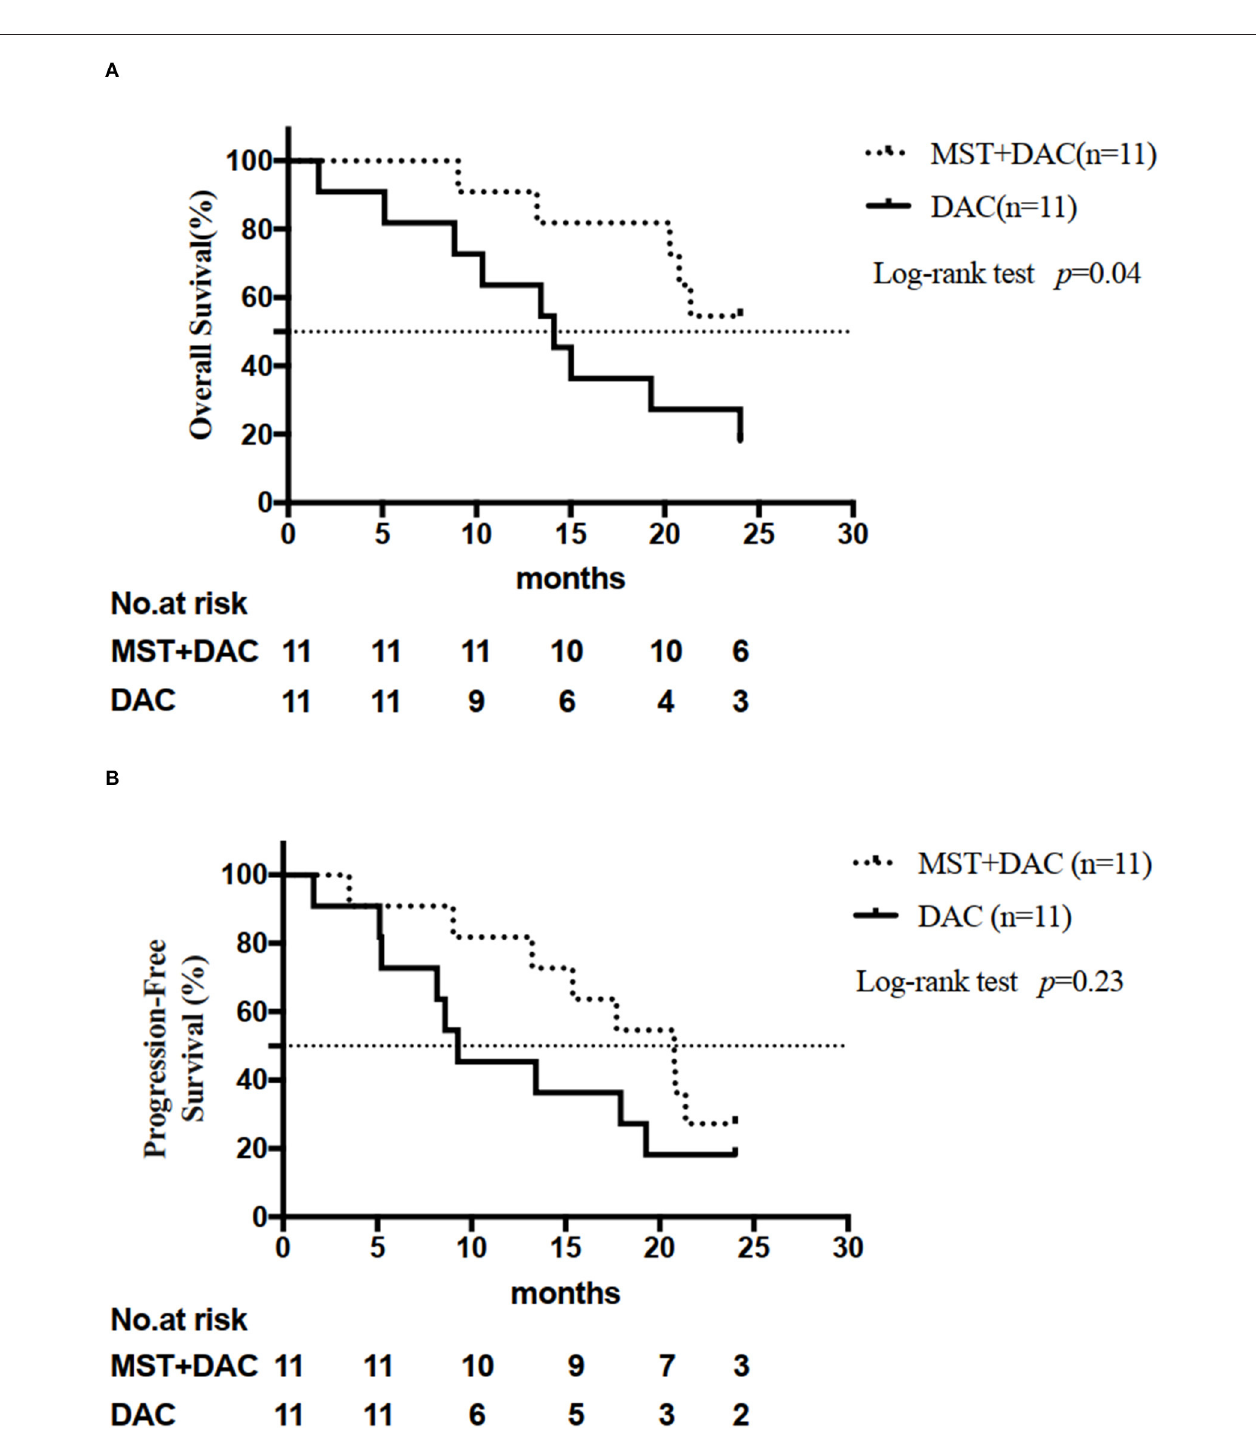
FIGURE 1 | Analysis of efficacy endpoints. (A) Overall survival (OS) for the two groups is shown. (B) Progression-free survival (PFS) for the two groups is shown. According to the toxicities reported in our study, there was a (24.0 [9.0–24.0 months] vs. 14.3 months [1.6–24.0 months], p = lower incidence of severe hematological AEs in the MST-DAC 0.04). However, due to the small number of cases included in our group during the entire treatment period compared with the retrospective study, future prospective trials with larger sample DAC only group: 27.2 vs. 54.5% for anemia ( p = 0.39); 54.5 sizes are needed to verify our results.